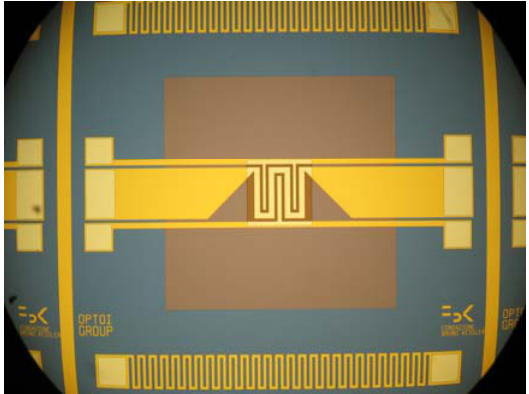
Figure 1. Pt microheater on SiO 2 /Si 3 N 4 membrane. Heater size is of ~300 × 300 μ m, maximum sensor working temperature is of 450 °C (FBK/NRC KI [2]).